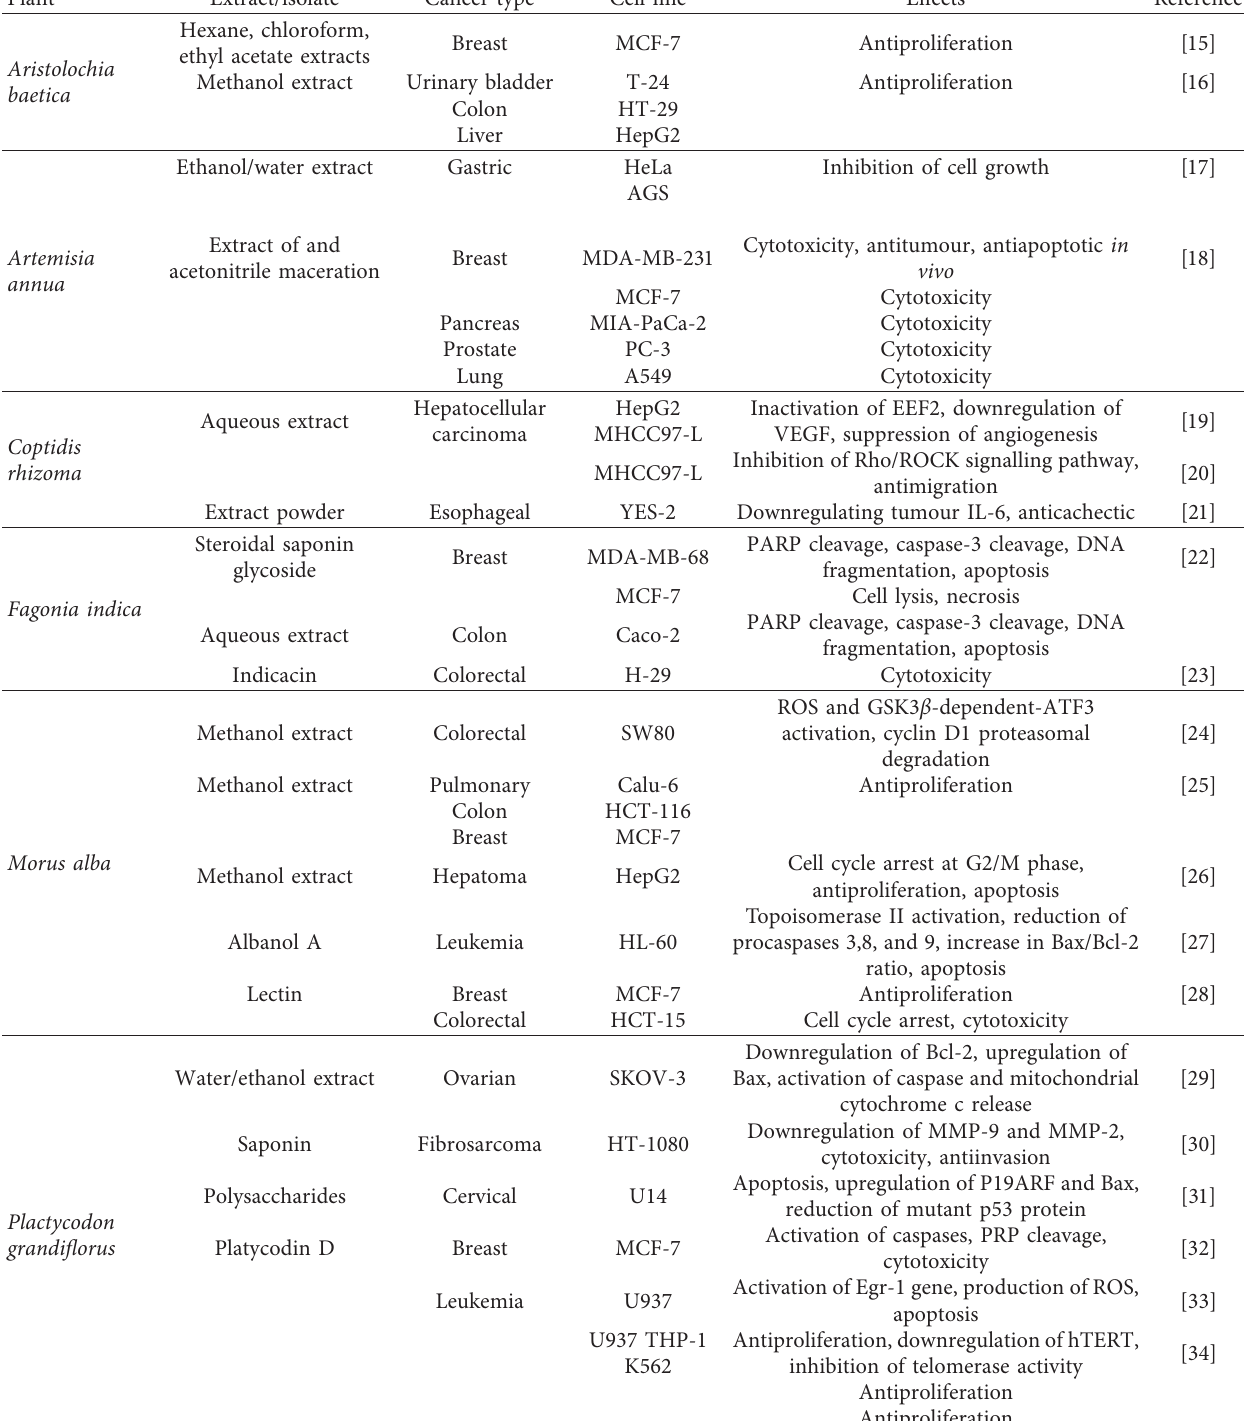
Table 1: The summary of anticancer effects of plant extracts and their isolates under